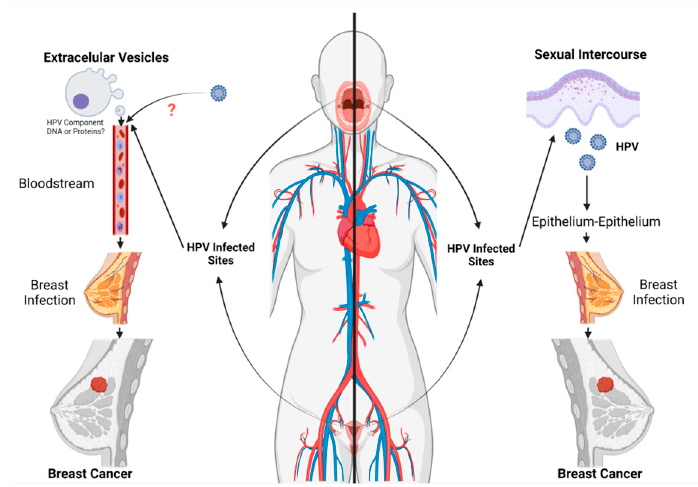
Figure 3. Possible HPV transmission routes. Two routes of HPV infection of the mammary epithelium are plausible. First, direct contact between an infected epithelium and the mammary epithelium. In this way, the virus can enter through microlesions that would allow infection and the expression of viral oncoproteins, which in collaboration with other factors can account for a breast tumor. On the other hand, extracellular vesicles (EV), which can be released to the bloodstream by HPV-infected cells, can transfer viral biomolecules to the breast. These biomolecules (EV cargo: proteins, nucleic acids, microRNAs) may go on to collaborate with other factors in tumor development.